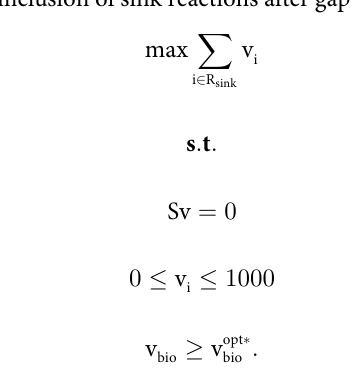
S1 Fig. Structural and sequence similarity of consensus reconstructions and isolate sequences to selected reference models. (A) The sensitivity (left) and precision (right) with respect to metabolite and E.C. number sets were calculated for each of the 432 reconstructions based on the two reference models. (B) Sequence similarity of 16S rRNA sequences of isolates to the ones of the two reference species. The red line depicts the median and the box limits rep- resent the 25% and 75% quartiles, respectively. The black dots indicate isolates that were assigned the same genus (9 for Bacillus megaterium and 27 for Methylobacterium extorquens ) according to Bai et al. [38]. Isolates that were predicted to belong to the same species are shown as red dots (2 for B. Megaterium and 5 for M. extorquens ). S2 Fig. Similarity of draft metabolic reconstructions to selected reference models. The sen- sitivity (left) and precision (right) with respect to metabolite and E.C. number sets were calcu- lated for each of the 432 reconstructions based on the two reference models. These values were scaled by the sequence similarity to the 16S rRNA sequences of the used references. (A) KBase [13] (B) CarveMe [14] (C) RAVEN 2.0 [17], and (D) AuReMe/Pathway Tools [15,16]. The black dots indicate isolates that were assigned the same genus (9 for Bacillus megaterium and 27 for Methylobacterium extorquens ) according to Bai et al. [38]. Isolates that were predicted to belong to the same species are shown as red dots (2 for B. Megaterium and 5 for M. extor-